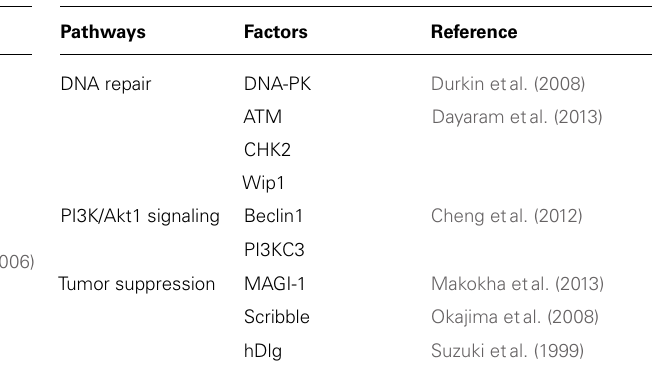
Table 1 |Tax-1 interacting proteins and deregulated